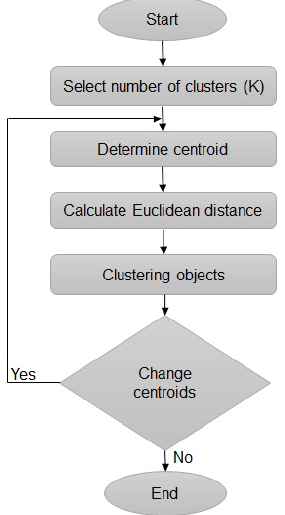
Figure 6. Overview of typical k-means